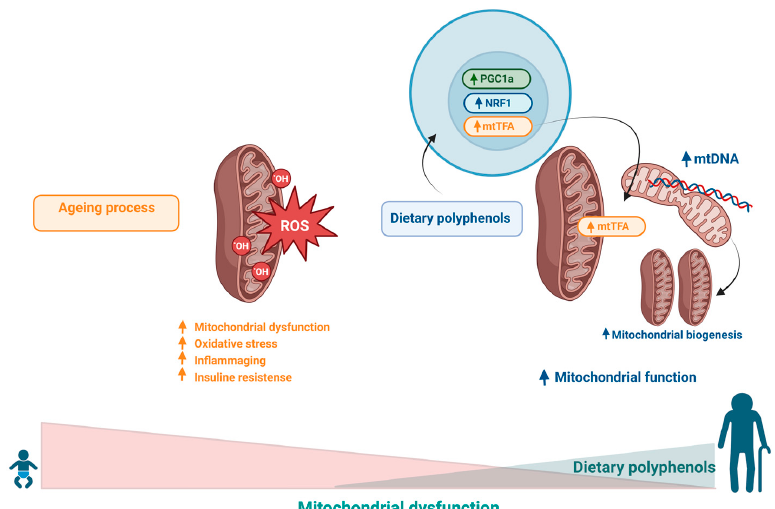
Figure 6. Oxidative damage to mtDNA results from the accumulation of free radicals within mito- chondria in response to the damage involved in the ageing process, which culminates in increased oxidative stress and reduced energy production. Dietary polyphenols could improve mitochon- drial function through the expression of PGC-1 α and mitochondrial transcription factor A (mtTFA), stimulating mitochondrial